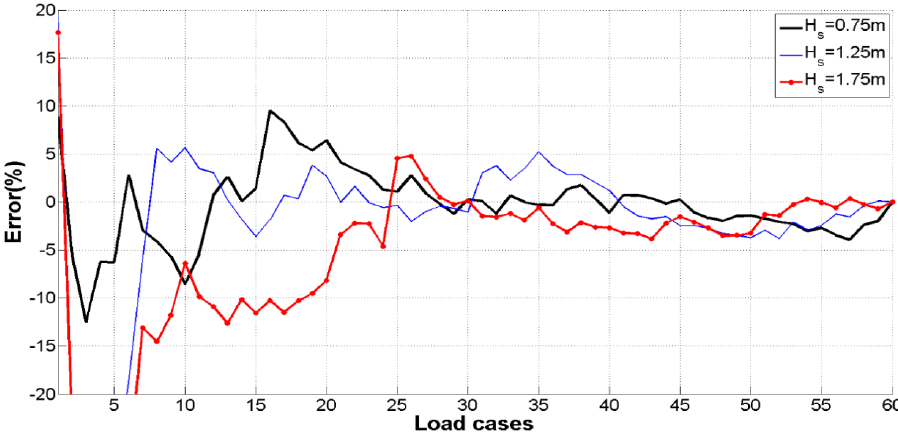
Figure 9. Simulation deviations (error) for the three wave-load-alone cases.